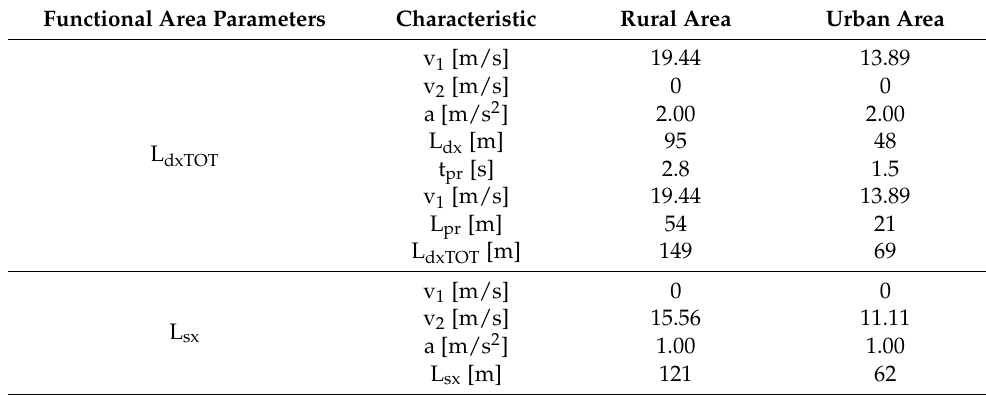
Table 1. L dxTOT and L sx assessment for the test site for the rural and urban areas. Functional Area